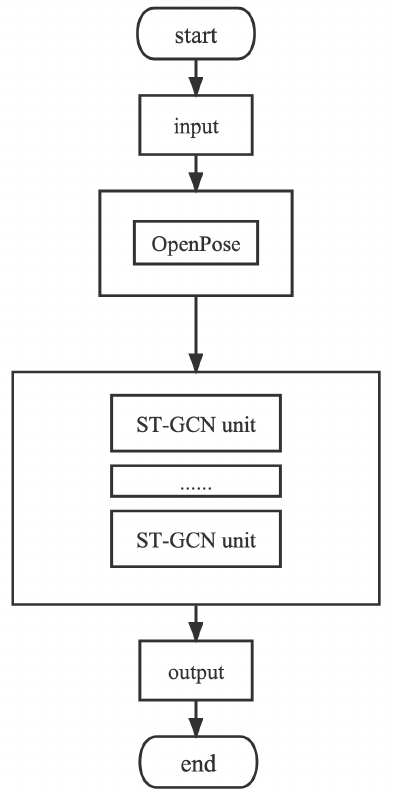
Figure 5. Flowchart of the improved